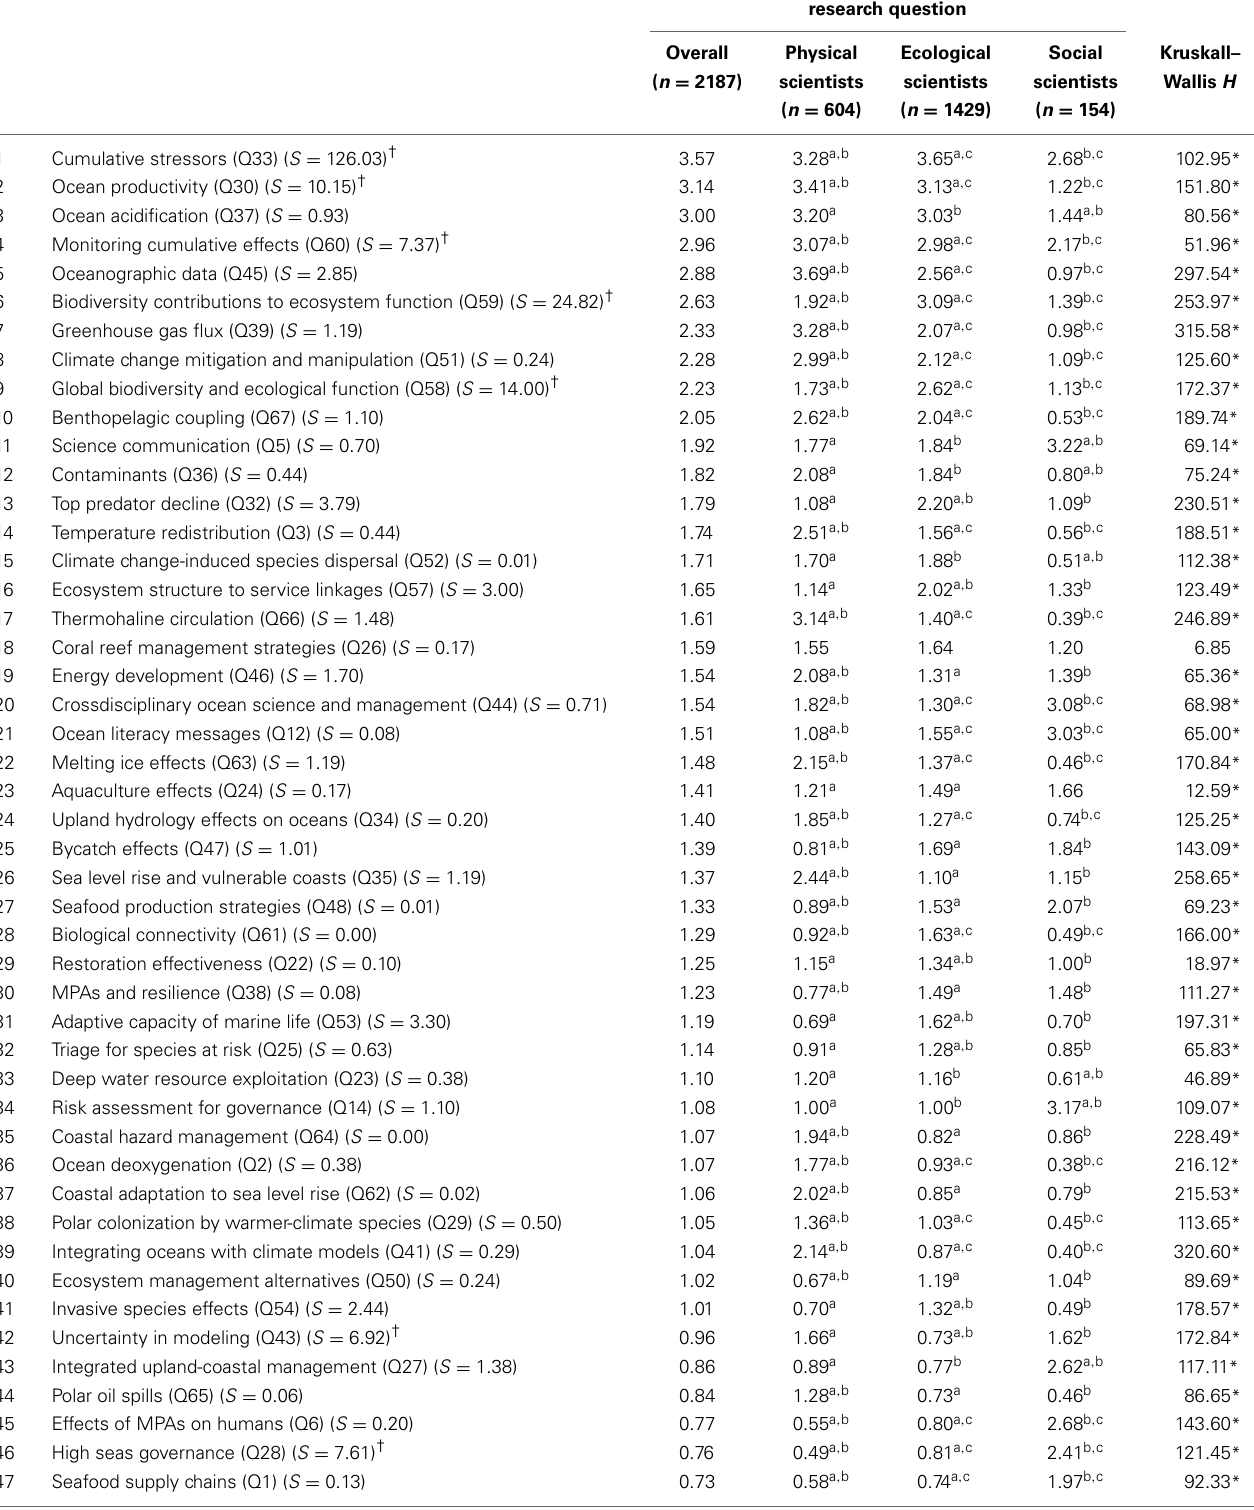
Table 5 | Differences in median ranking score for the top-ranked question (cumulative stressors) by respondents belonging to different demographic and professional